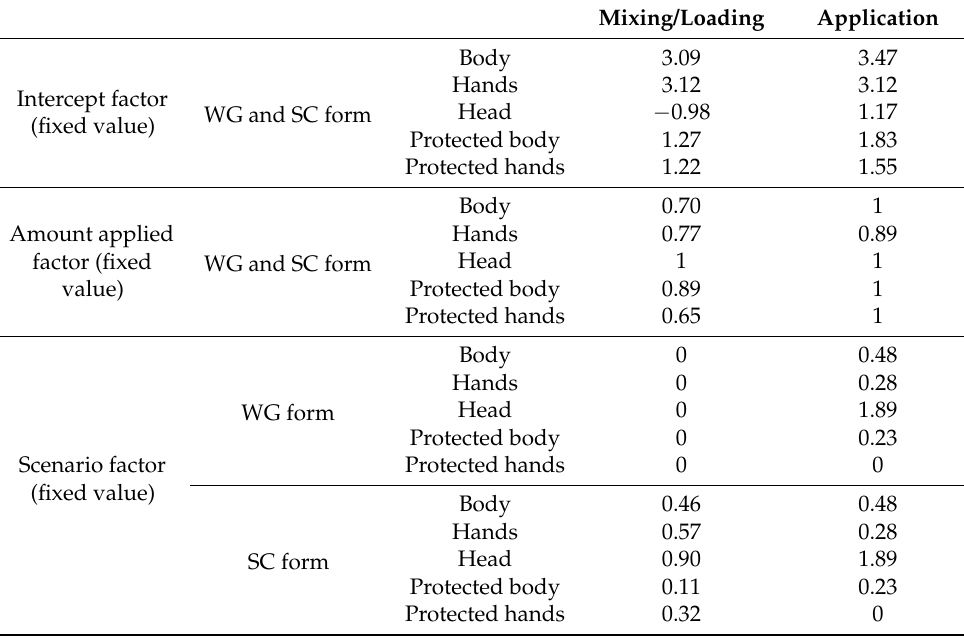
Figure A1. Patches (10 cm × 10 cm) Used to Measure Dermal Exposure and Extrapolation Coefficients (EC) Corresponding to Each Body Part. Table A1. Intercept Factor, Amount Applied Factor and Scenario Factor for Outdoor Upward Spraying with Vehicle Mounted Sprayer (AOEM).